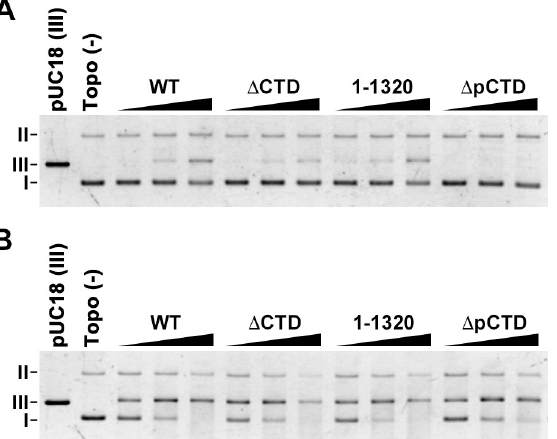
Fig 3. The pCTD of rat topo II β supports pre-strand passage DNA cleavage activity. (A) DNA cleavage assay was performed in the absence of ATP. FLAG-tagged protein (50, 100, and 200 fmol) was mixed with 5 ng pUC18 in the presence of 200 μ M etoposide and incubated at 37˚C for 15 min. Deproteinized samples were analyzed by 1% agarose gel. (B) DNA cleavage assays were performed in the presence of AMP-PNP as described in (A). I: supercoiled DNA. II: nicked circular DNA. III: linearized